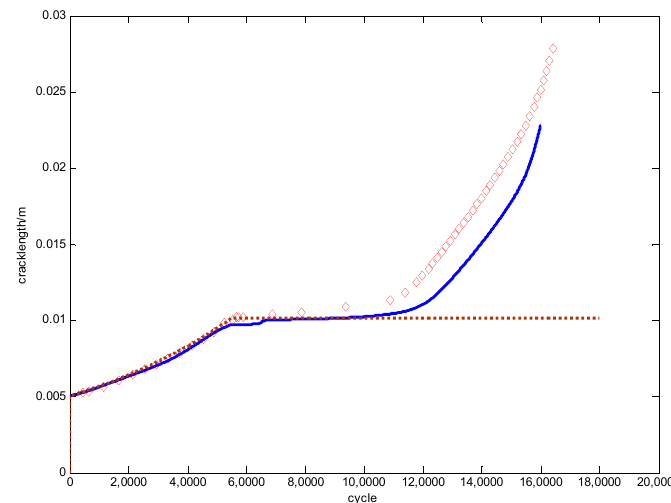
Figure 21. The predictions vs. the experimental data for D16 aluminum alloy.